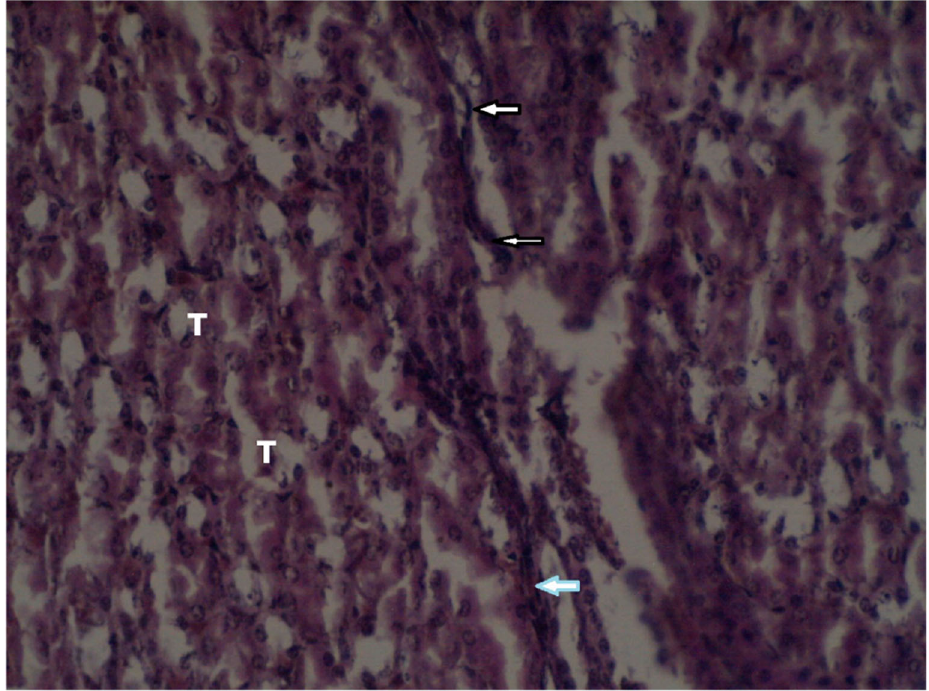
Figure 3. Localized interstitial connective tissue proliferation shown by the arrow indicating multifocal kidney interstitial hemorrhage in the intermediate dose group ( (cid:1) 400). No adjustments were made in terms of contrast or